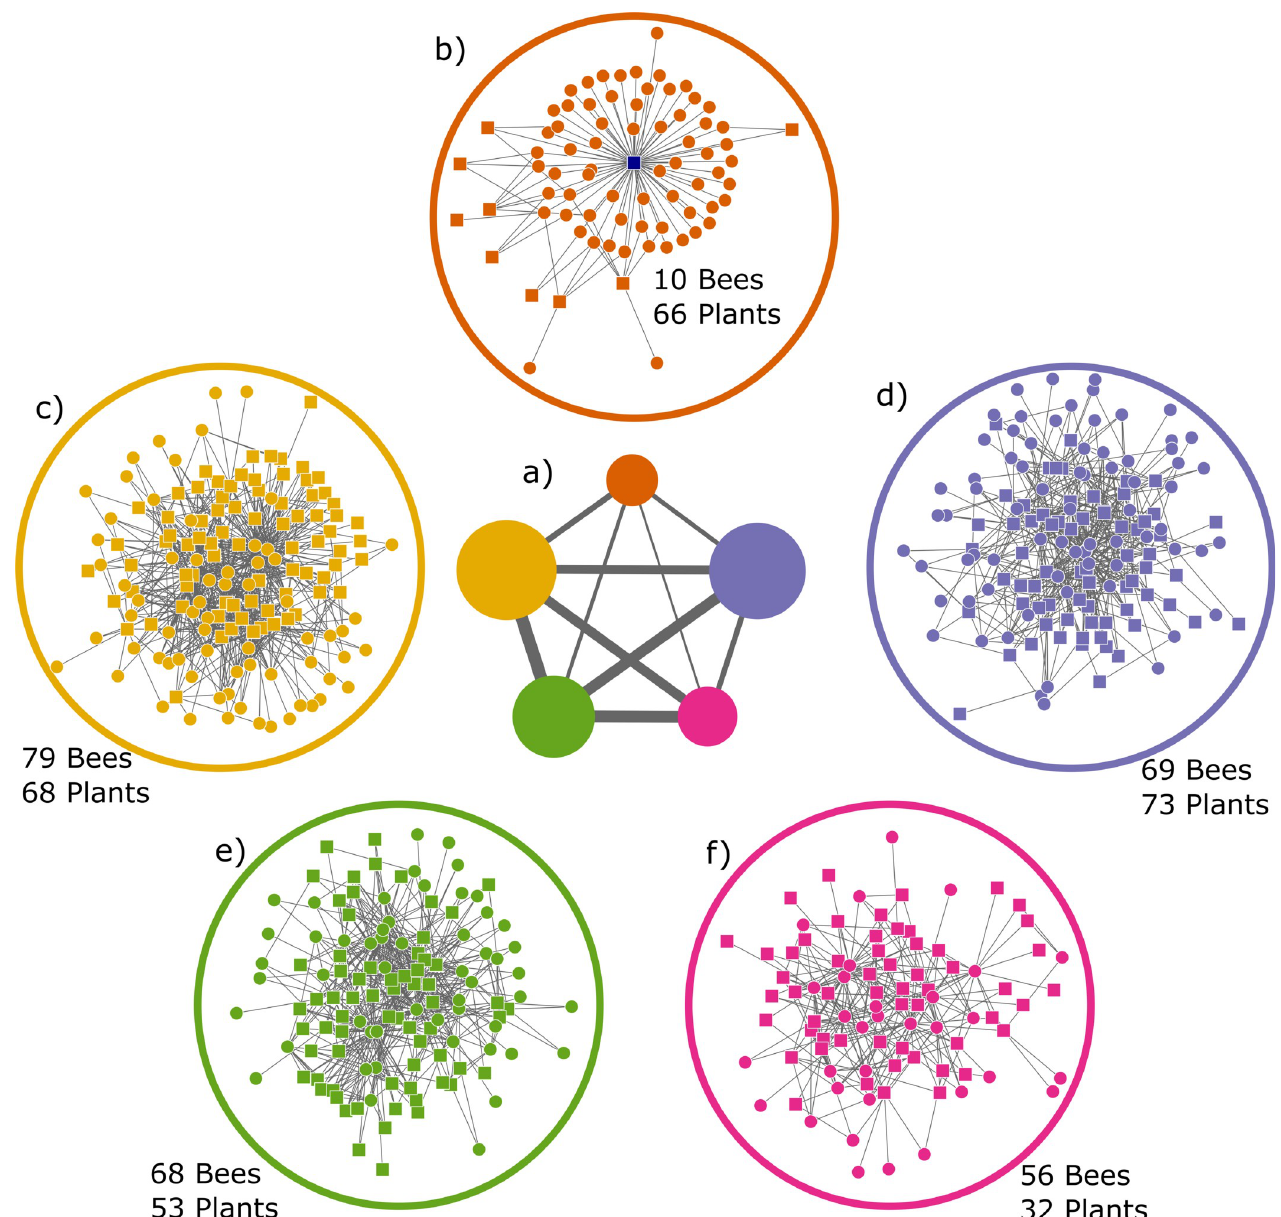
Fig 5. Graph of the five modules. a) Size of circles (modules) are proportional to number of both plant and bee species in each module, thickness of lines connecting modules are proportional to number of interactions between the modules. b-f) the five different modules identified from a, squares are bee species, circles are plant genera. Modules b to f are presented in the same position as they appear in a, with module b in top. Honey bee is the central square (blue) in the module